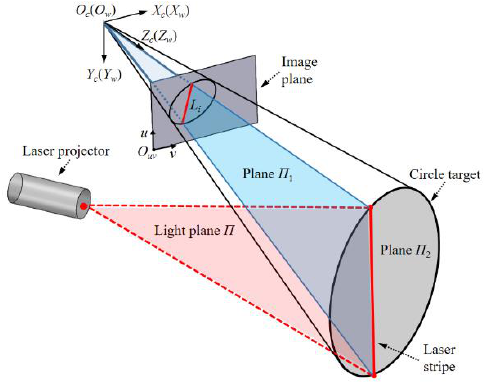
Figure 5. Schematic diagram of the light plane determination process.